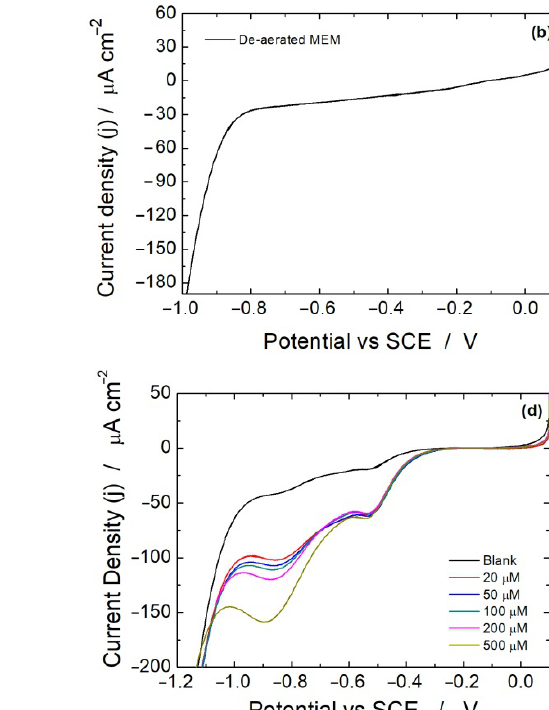
7 of 18 Figure 2. Calibration line obtained with CH at −8 00 mV vs. SCE in ( a ) diluted MEM, ( b ) diluted DMEM, ( c ) diluted Ham’s F12 and ( d ) diluted B/D medium (N = 3). From the results reported in Table 1, it can be concluded that the best medium for chronoamperometry quantification of H 2 O 2 is the RPMI. This result is attributable to the different media compositions. Table 1. Features of the AuNPs-rGO-based sensors using CH at −8 00 mV vs. SCE as the electro-